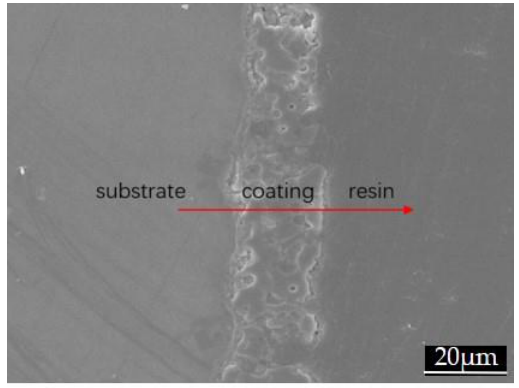
Figure 7. Cross-sectional SEM morphology of the PEO